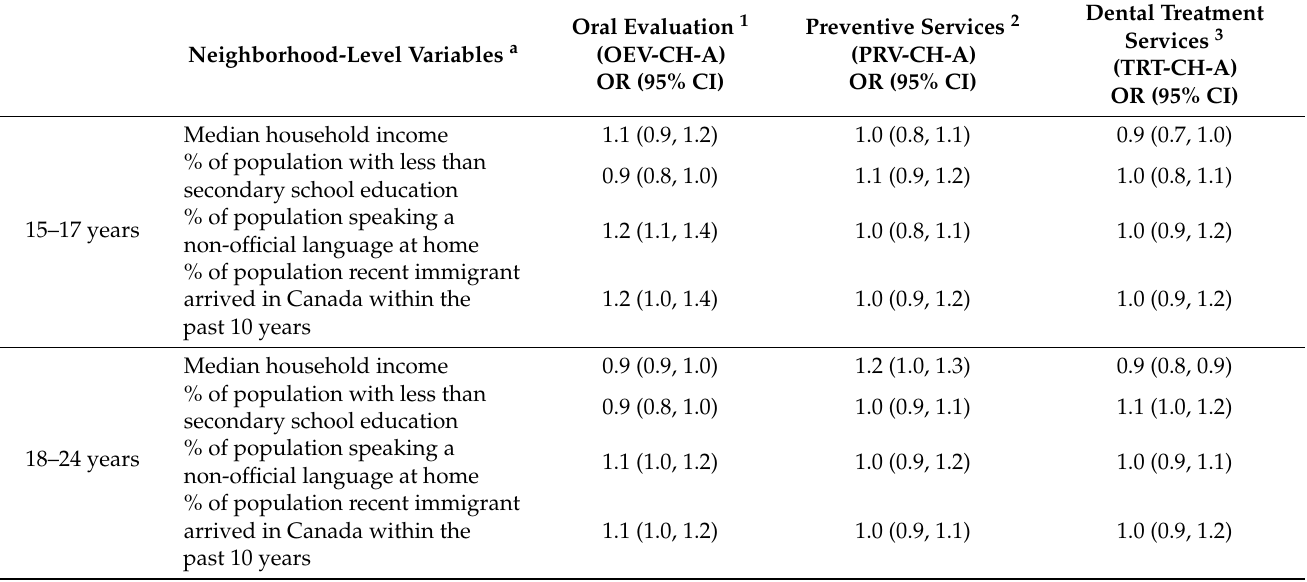
Table 3. Binary logistic regression models for the associations between dental care outcomes and neighborhood-level demographic variables.